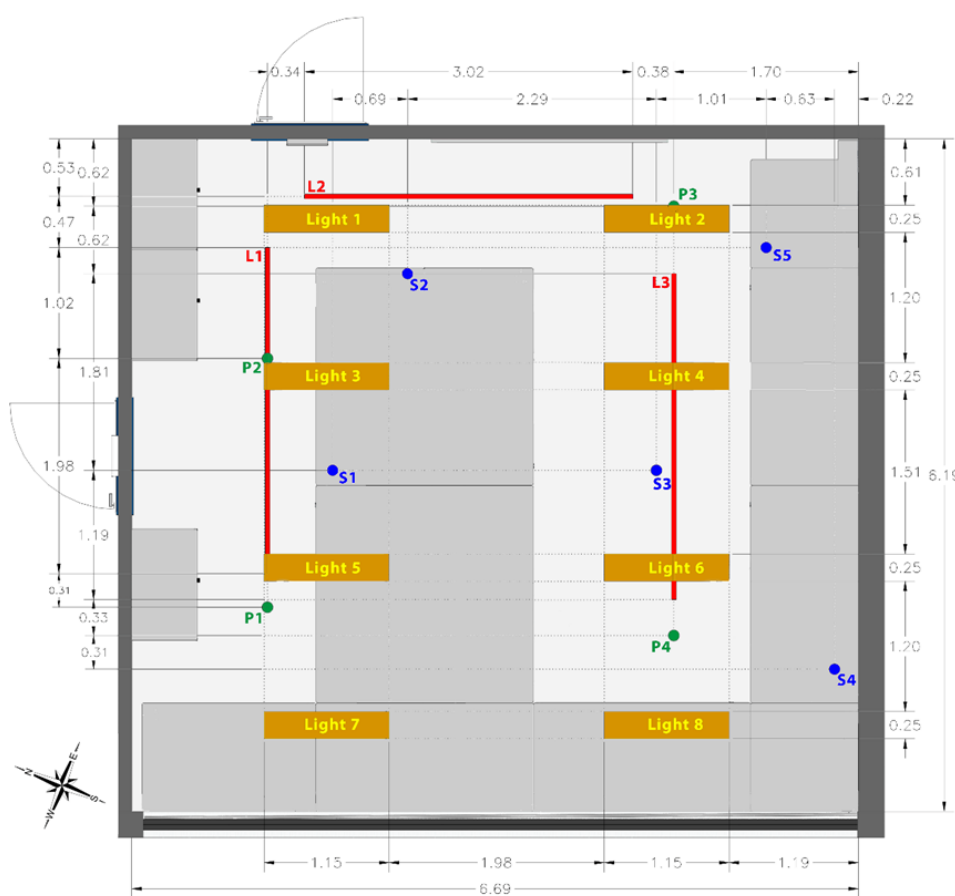
Figure A1. Room 1 (R1) floor plan with test points (P1–P4) and test lines (L1–L3) for the performance of physical activities and spectrum test points (S1–S5).